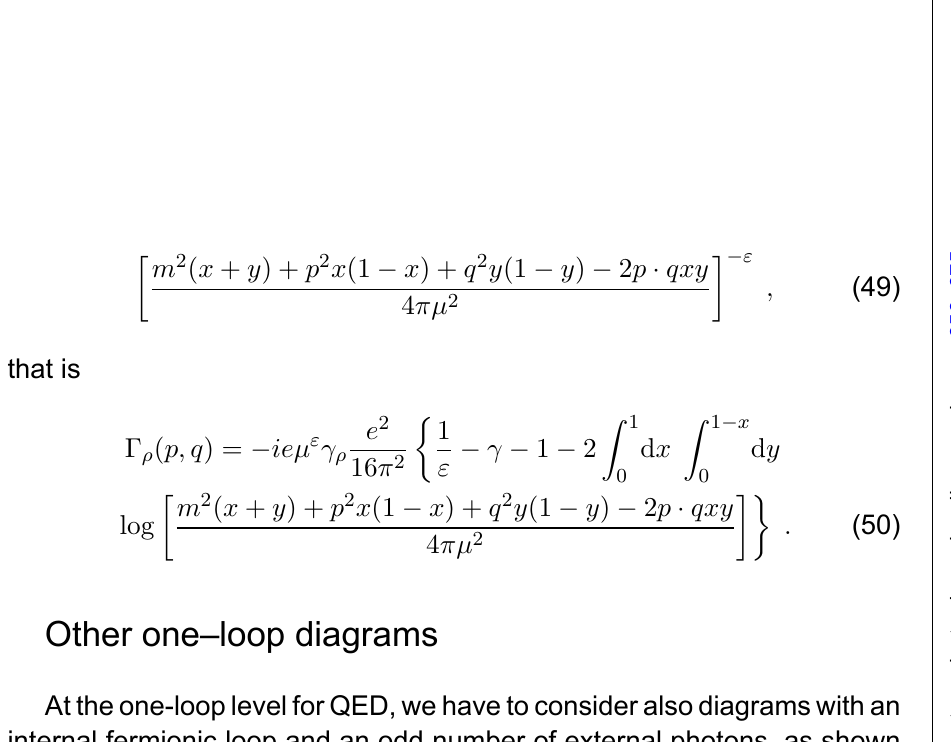
Figure 5 – Three external photons Рис. 5 − Три внешних фотона Слика 5 – Три спољашња фотона